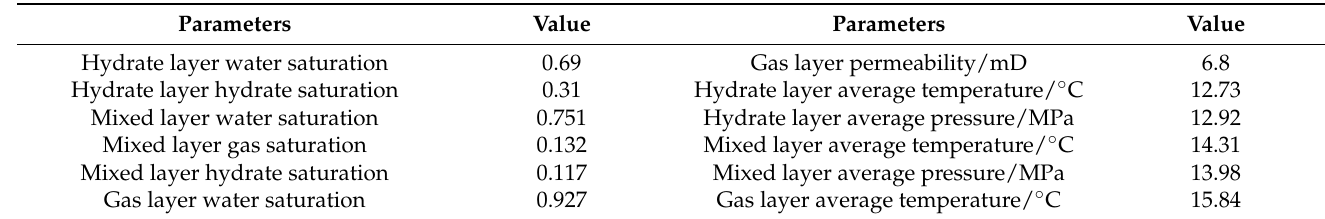
Table 1. Hydrate deposit properties and initial conditions in the Shenhu area